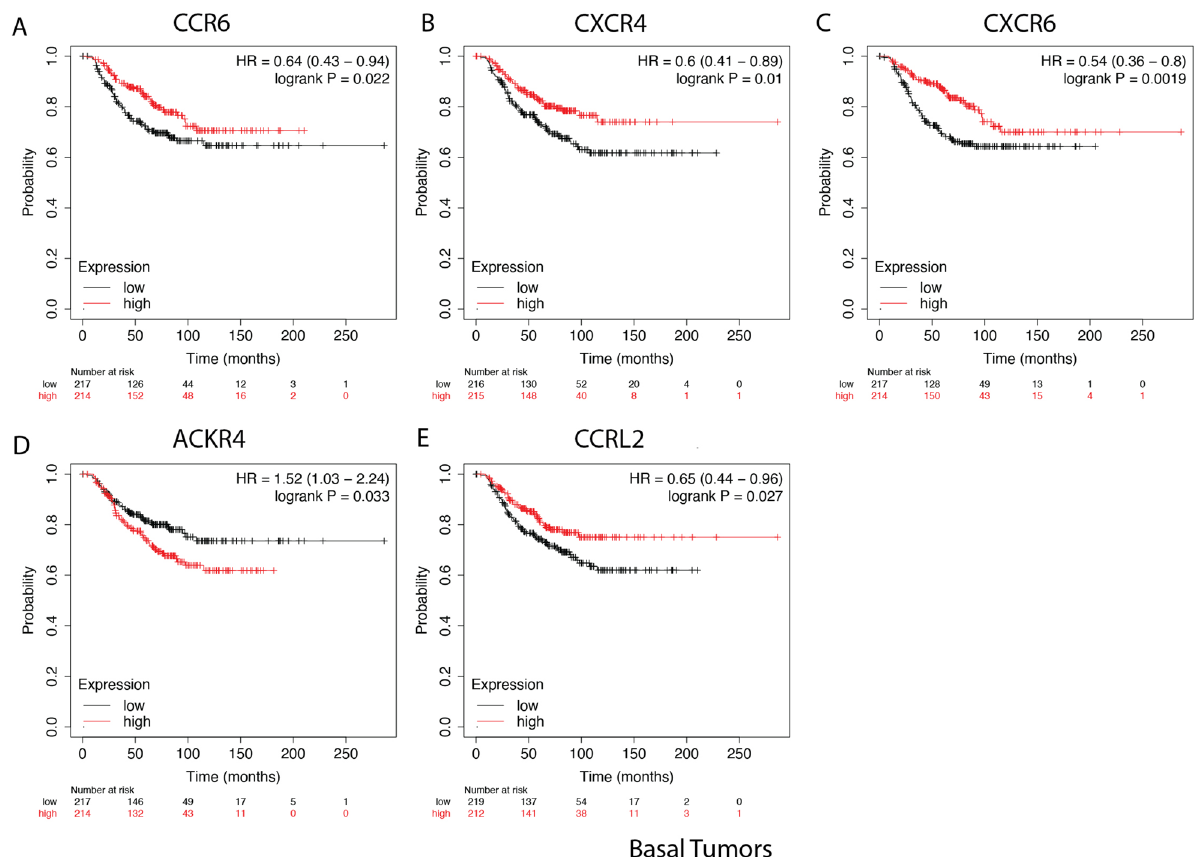
Figure 9. Overall survival rate of breast cancer patients tumor samples of basal subtype. Kaplan–Meier curves of overall survival based on KMplotter mRNA gene chip expression of chemokine receptors in breast cancer patients. Red line represents higher expression and black line represents lower expression. Patients with a high expression of the genes for ( A ) CCR6, ( B ) CXCR4, and ( C ) CXCR6, ( D ) ACKR4 and ( E )